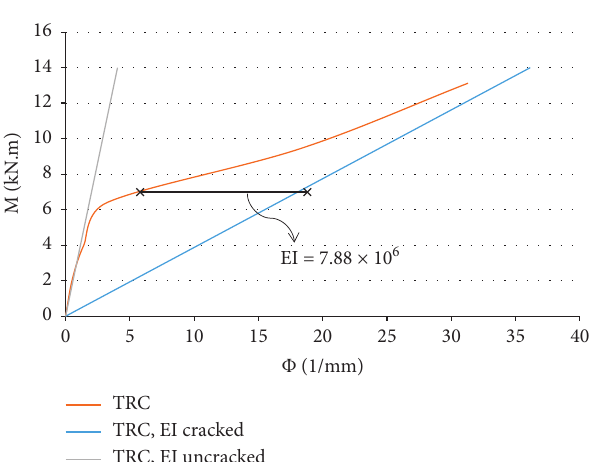
Figure 10: Tension stiffening of TRC beams.